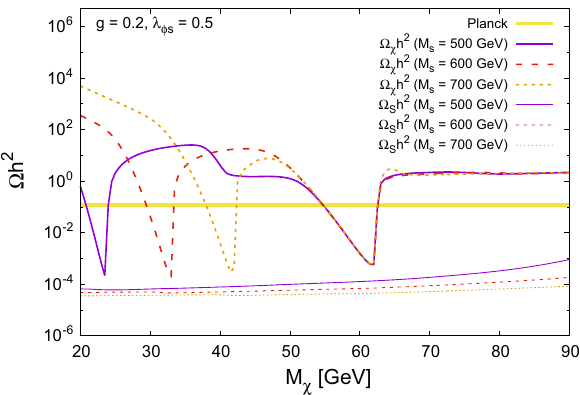
Fig. 2 Relic density as a function of fermionic DM mass for different values of the scalar mass M s